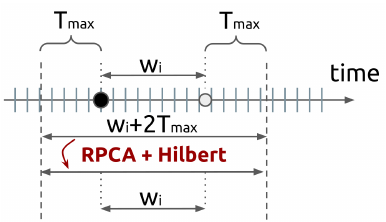
Figure 4. Sub-video generation from a video; the time step between frames is 1 fps (fps = frames per second).